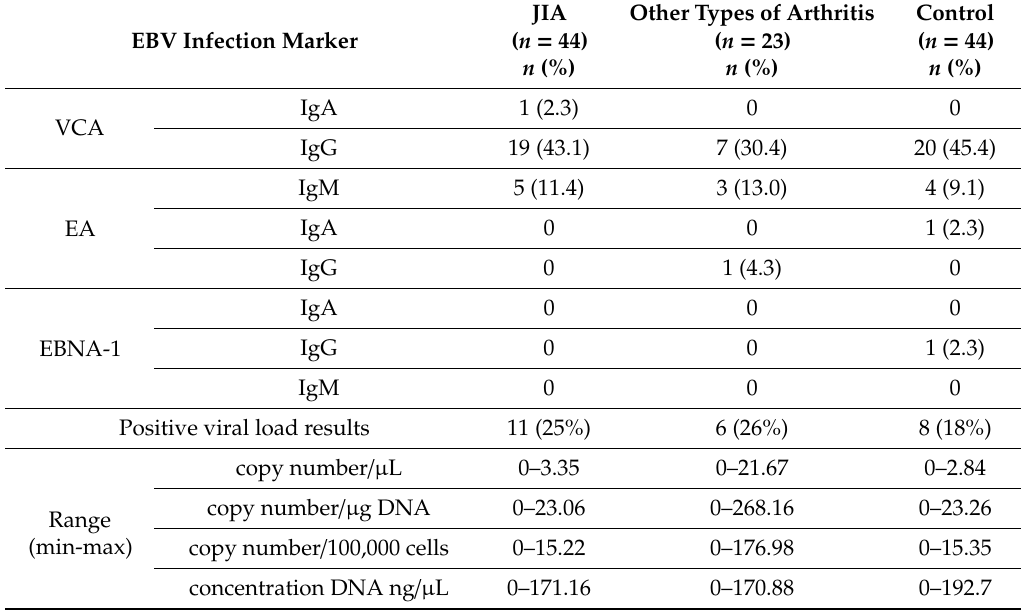
Table 4. Frequency of positive results of anti-EBV antibodies and positive viral load results in patients with JIA, other types of arthritis, and controls.